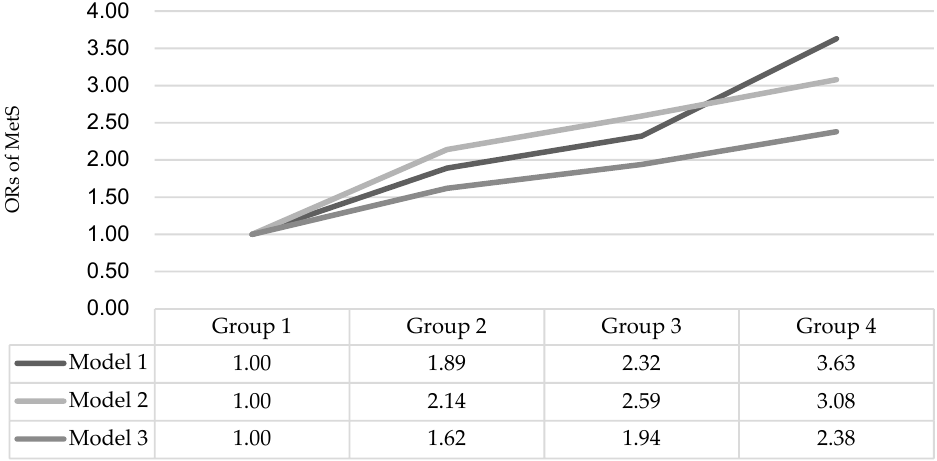
Figure 1. Nonlinear dose–response relationship between selenium and metabolic syndrome. ( A ) All subjects; ( B ) Female subjects; ( C ) Male subjects.